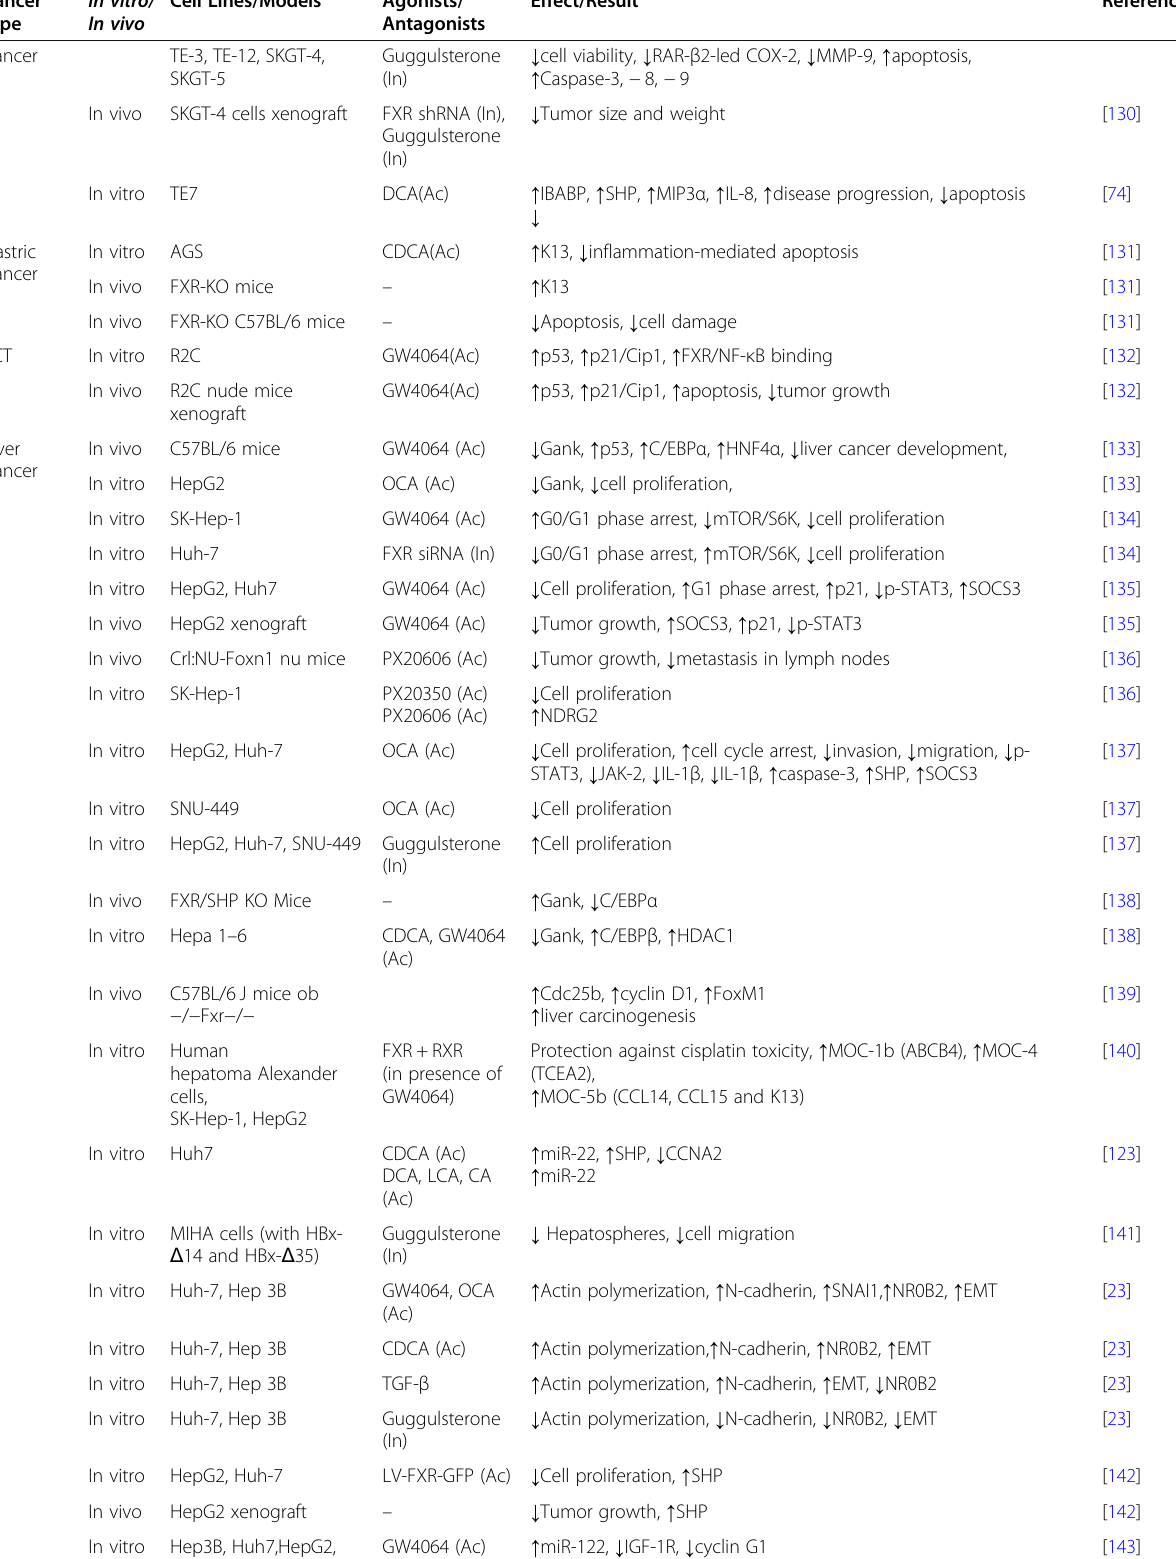
Table 1 Mechanistic role of FXR in various cancers in the presence of its agonists/antagonists (Continued) Cancer